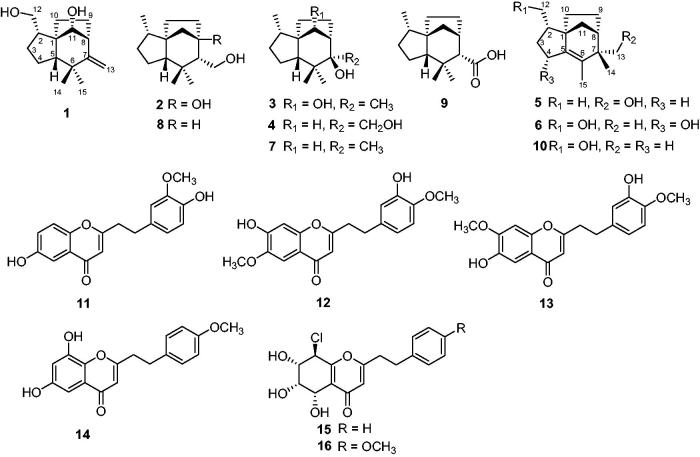
Structures of 1–16.